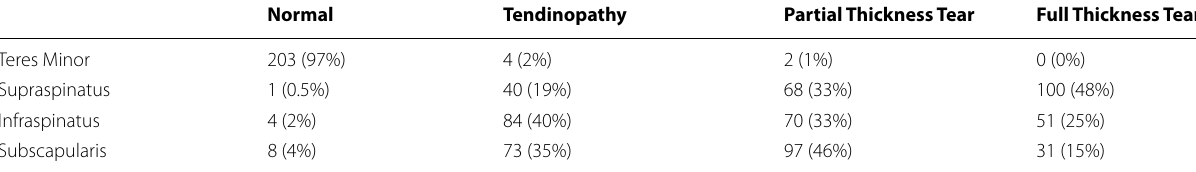
Table 2 Rotator cuff tendon pathology associated with teres minor fatty infiltration Normal Tendinopathy Partial Thickness